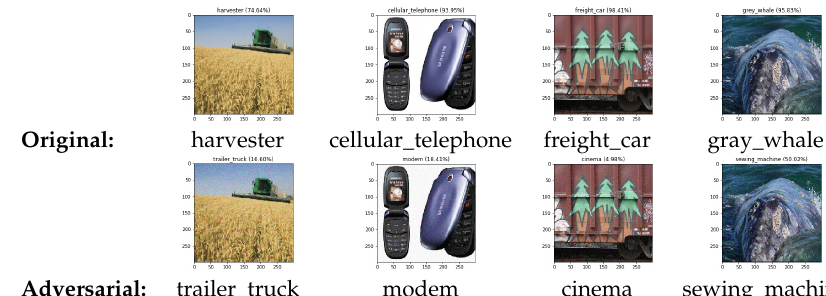
Figure 4. Our adversarial examples on ImageNet with B set to 0.05.